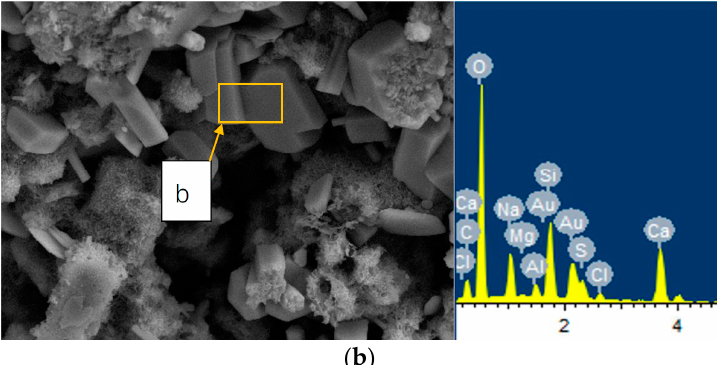
Figure 1. SEM images and corresponding EDS results in concrete exposed to 10% sulfate solutions for ( a ) precast concrete, magnification = 5 K, and ( b ) cast-in-situ concrete, magnification = 2.5 K.